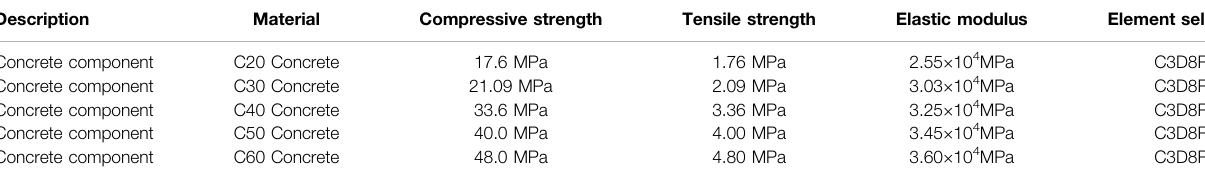
FIGURE 11 | Finite element model of BFJ. TABLE 6 | Material properties in fi nite element model. Steel Concrete material properties.